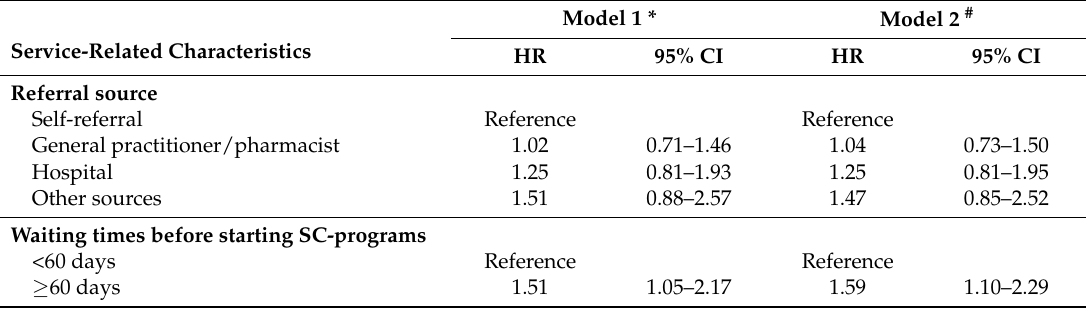
Table 2. Risk of treatment failure at 12 months in relation to referral sources and waiting times at the smoking cessation service of Reggio Emilia,